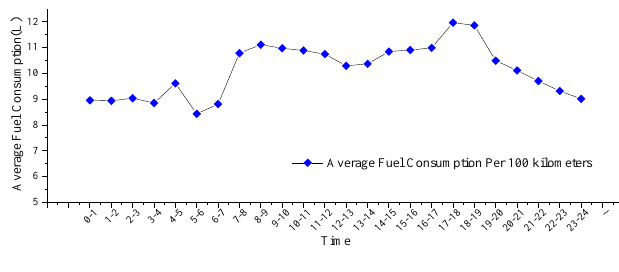
Figure 10. Average fuel consumption throughout one day. Table 4. Investigated fuel consumption per 100-km (FCPOK) results (L/100 km).